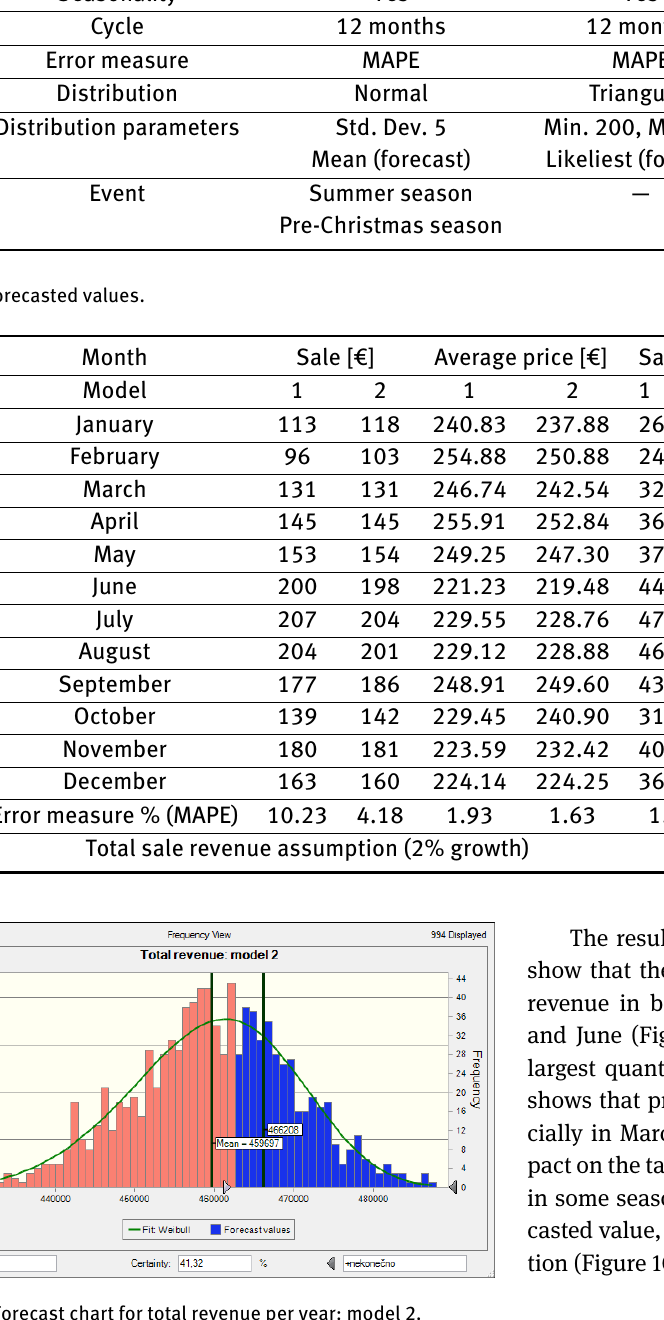
Figure 8: Forecast chart for total revenue per year: model 2.